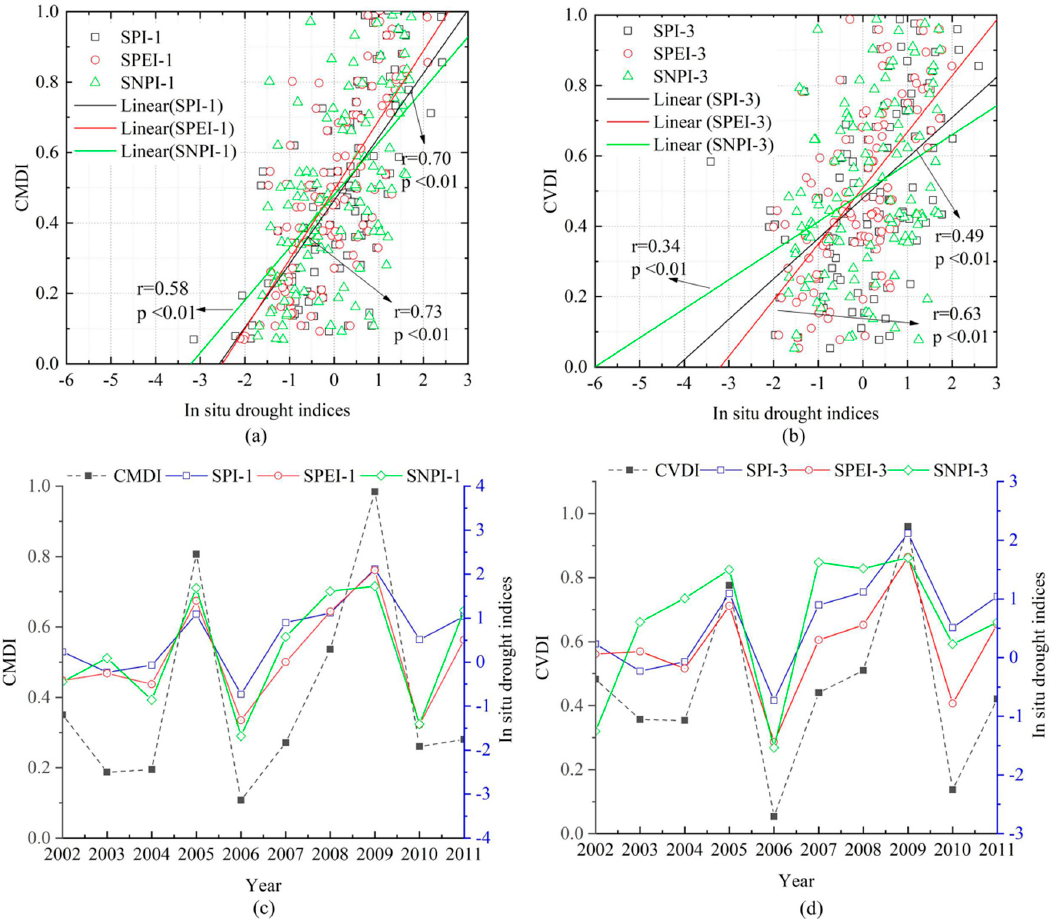
Figure 2. Comparisons of combined drought indices and in situ drought indices ( a ) scatter plots of monthly CMDI and 1-month in situ drought indices, ( b ) scatter plots of monthly CVDI and three-month in situ drought indices, ( c ) year-to-year changes in July of CMDI and 1 month in situ drought indices, and ( d ) year-to-year changes in July of CVDI and three-month in situ drought indices.